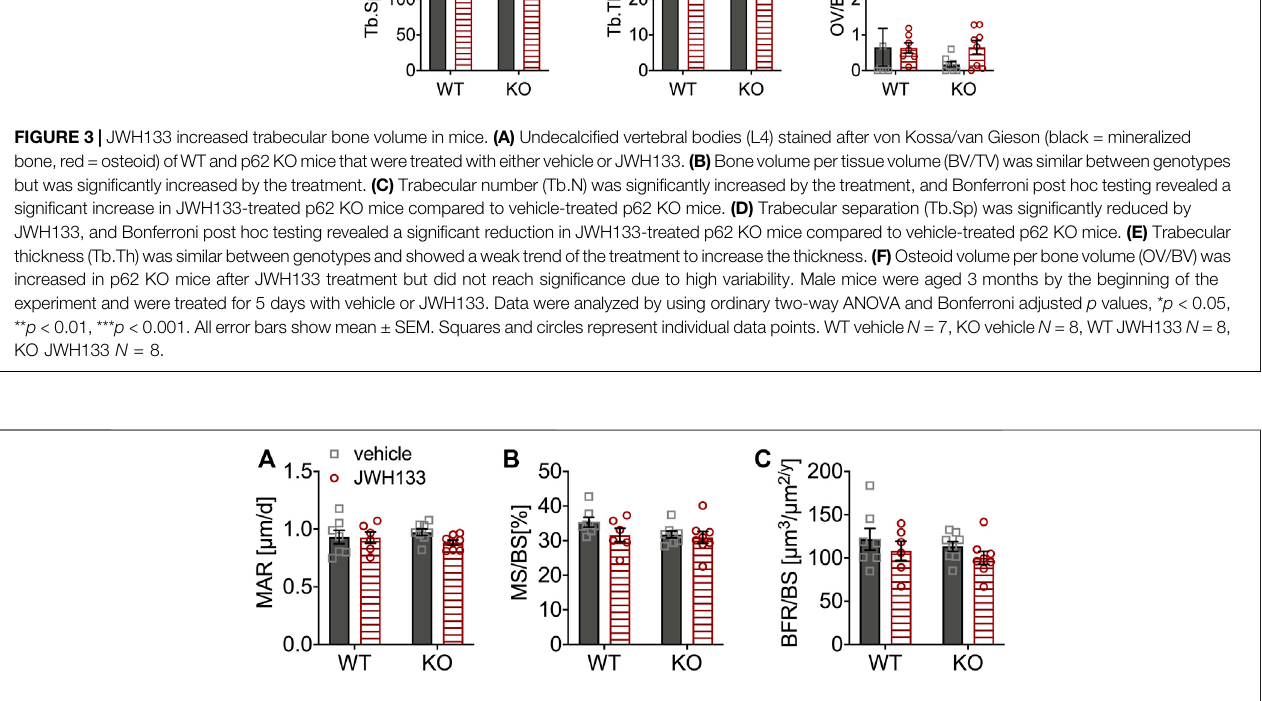
of bone surface occupied by osteoblasts was reduced in vehicle- treated p62 KO mice compared with vehicle-treated WT mice but did not reach signi fi cance. Treatment of mice with JWH133 signi fi cantly increased the percentage of osteoblasts per bone surface in p62 KO mice ( Figure 5B : KO vehicle, 4.0 ± 0.6%, N = 8; KO JWH133, 10.7 ± 2.4%, N = 7: p = 0.01), while WT mice were not affected, resulting in a signi fi cant effect of interaction (interaction = F (1.26) = 4.5, p = 0.04) and trend in the effect of treatment (treatment = F (1.26) = 3.9, p = 0.06) ( Figure 5B ). Next, osteoclasts were analyzed, revealing nearly identical numbers of cells in vehicle-treated p62 KO and WT mice ( Figure 5C ). Treatment with JWH133 signi fi cantly increased the number of